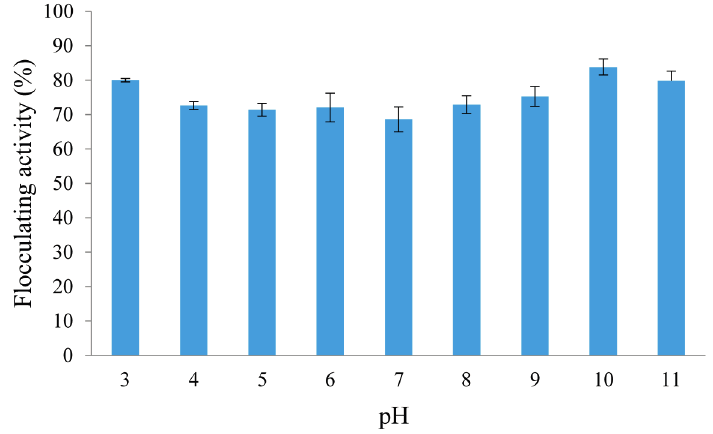
Figure 5. Effect of pH on the flocculating activity of crude REG-6 produced by Bacillus toyonensis strain